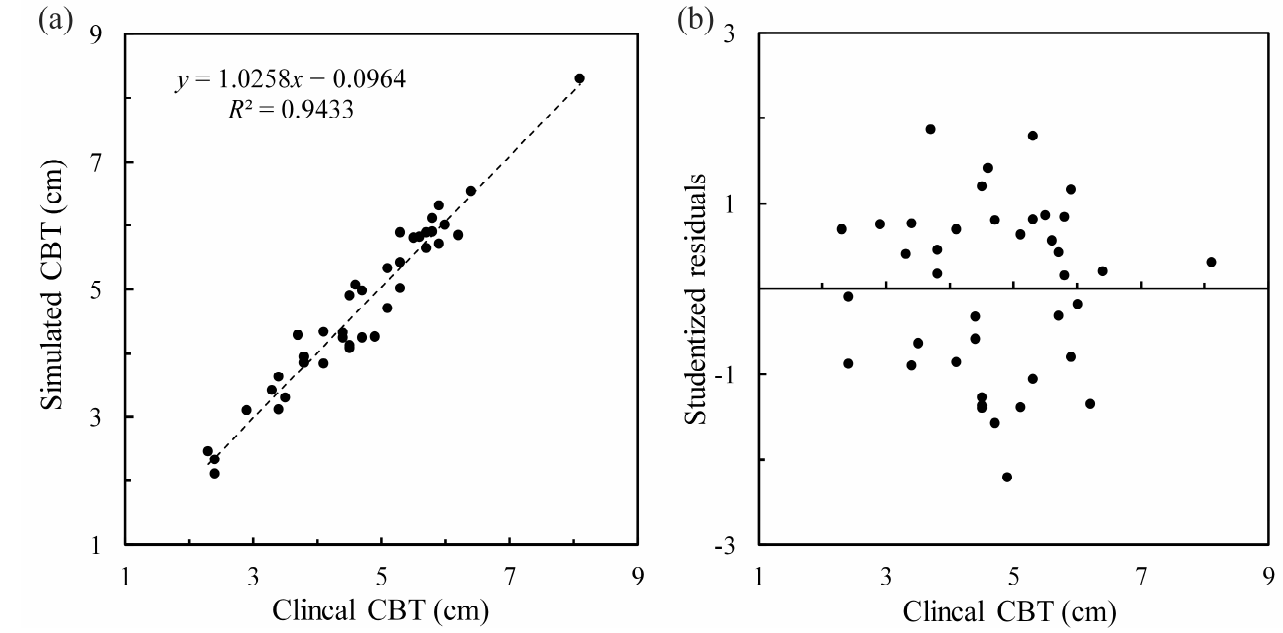
Figure 7. ( a ) Scatter plot of the simulated CBT and the clinical CBT at the same clinical compression force, and ( b ) the studentized residual plot as a function of clinical CBT. The residuals are scattered throughout the clinical CBT without showing any clear trend.